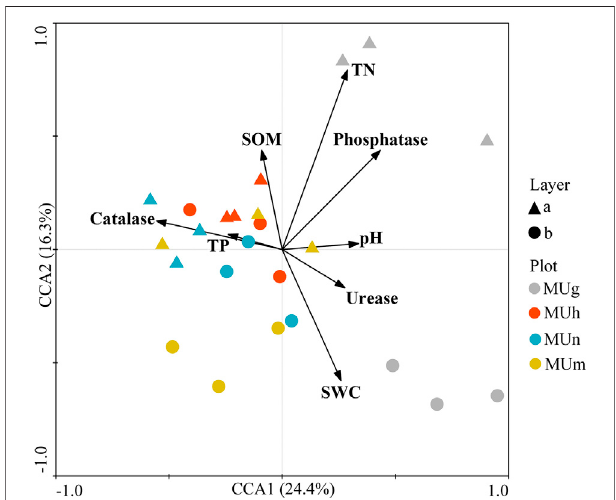
FIGURE 4 | CCA of the soil fungi communities with soil properties in different soil depths through revegetation durations. Each arrow points in the expected direction of the steepest increase of values of environment variable. The angles between arrows indicate correlations between individual environment variable.